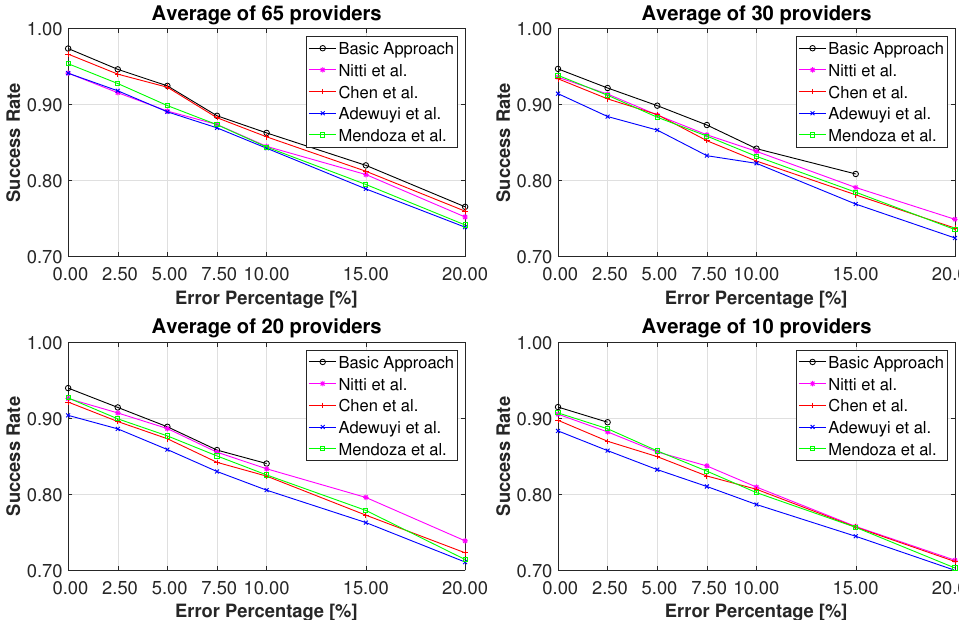
Figure 4. Transaction success rate for different averages of providers and error percentages.